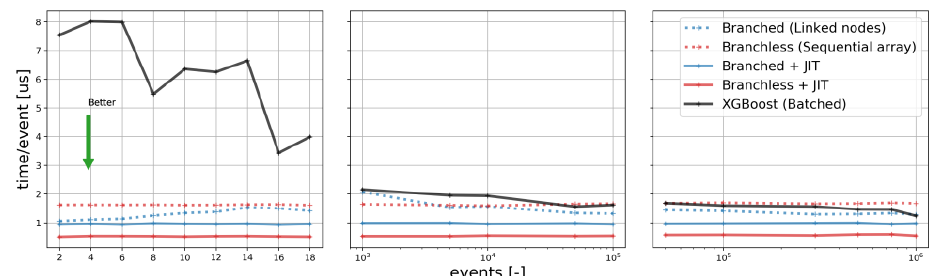
Fig. 3. Speedup in inference by adopting the JIT and the branchless representation techniques, in comparison to vanilla XGBoost implementation.